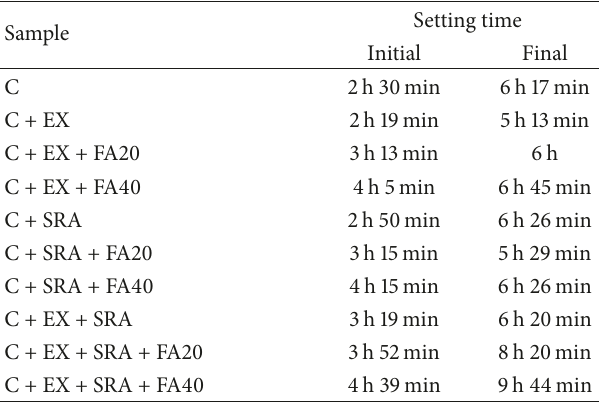
Table 4: Initial setting time and final setting time of mortar mixed with EX, SRA, and FA.